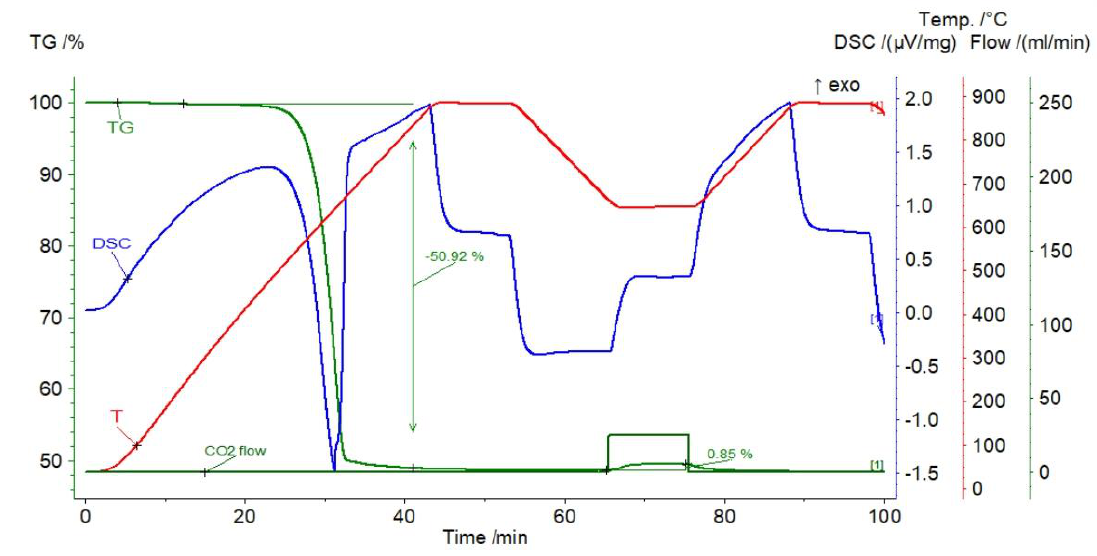
Figure 11. TGA and DSC curves for magnesite.